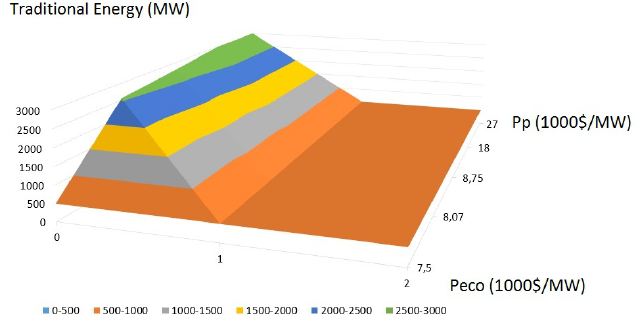
Figure 3. Variation of the optimal traditional energy contract capacity with respect to P eco and P p in case of certainty (own results).